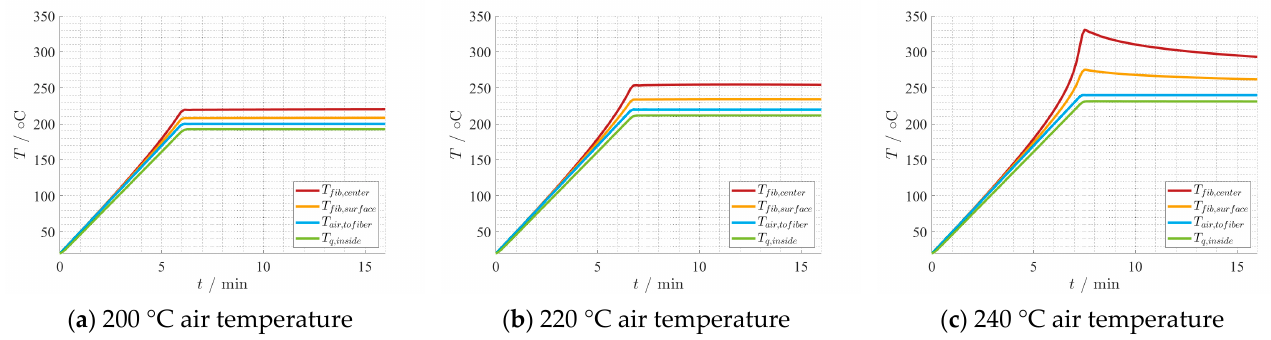
Figure 14. Thermal development depending on 1 W microwave power and different air temperatures overtime.